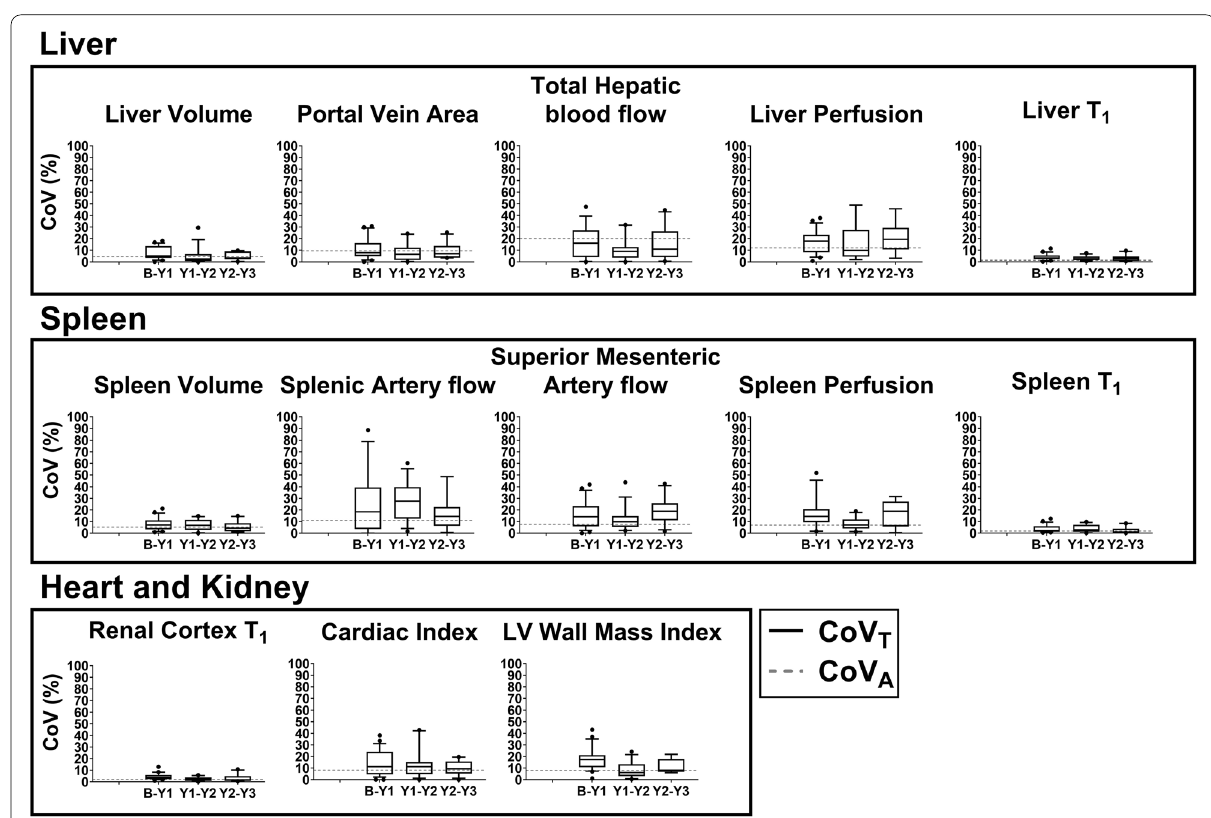
Fig. 5 Year-to-year coefficient of variation (CoV T ) in magnetic resonance imaging measures in the stable compensated cirrhosis control group. Bars indicate the interquartile range and the horizontal bold line shows the median CoV T at each time point, dots represent outliers. The technical variation termed the analytical CoV (CoV A ) measured in healthy volunteers from triplicate scans collected 1 week apart [10] is shown by the grey dashed